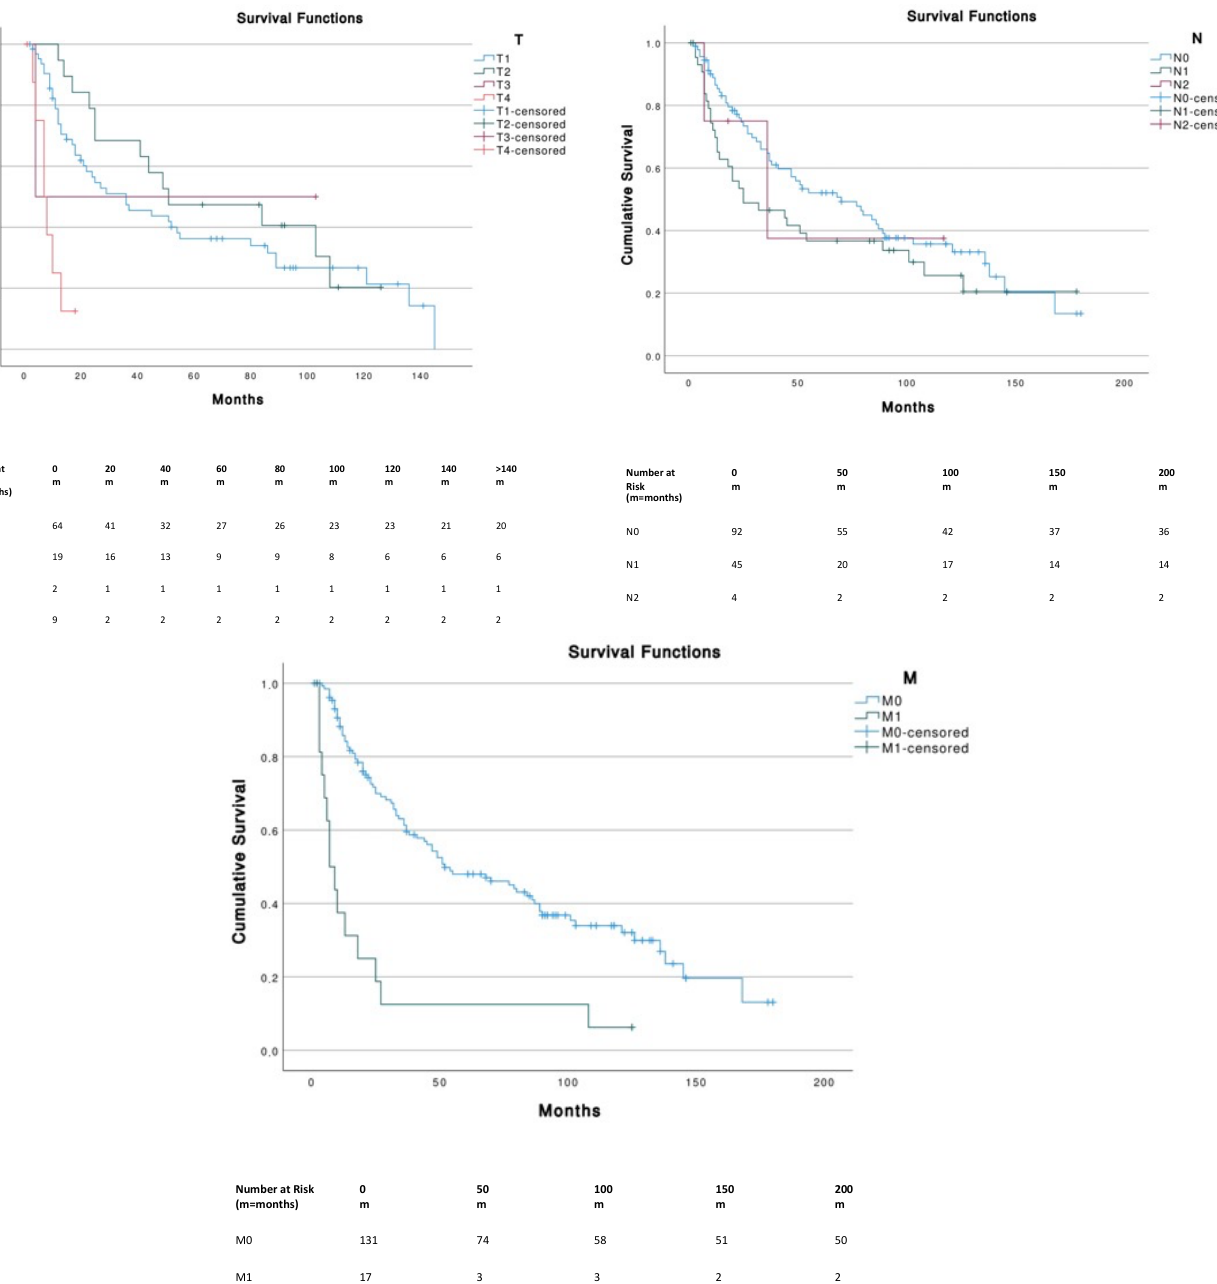
Figure 2. Survival distribution according to age and gender . Patients with tumor sizes ≤ 5 cm corresponding to T1 ( ≤ 2 cm) and T2 (2–5 cm) had a significantly ( p < 0.001) higher OS compared to T4 (i.e., primary tumor invades fascia, muscle, cartilage or bone). No significant differences were found across different N stages. The presence of metastasis (M1) was associated with a significantly ( p < 0.001) lower survival (median, 7 months; 95% CI, 3.1–10.9) compared to M0 (median, 52 months; 95% CI, 26.3–77.7) (Figure 3).